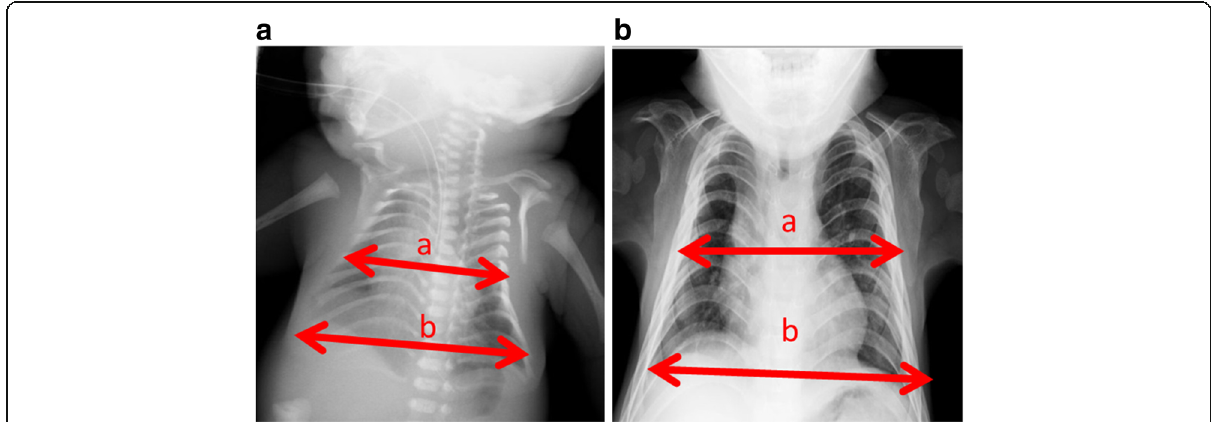
Fig. 2 Examples of M/W ratios (the ratio of the mid to widest thoracic diameter.) M/W ratio= a / b ×100. a At birth. The M/W ratio was 67% (normal range 82 – 89%). b At 1 year 10 months (before operation). The M/W ratio was 79% (normal range 83 – 98%). The M/W ratio tended to improve with